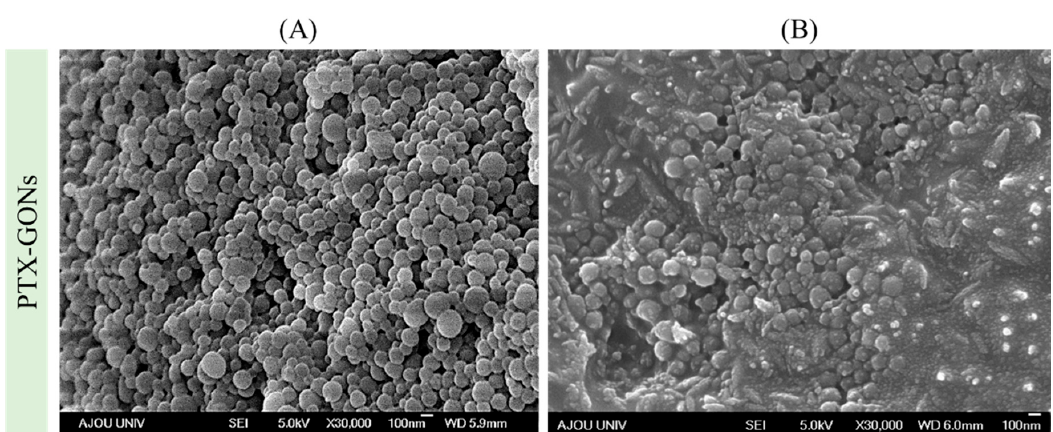
Figure 4. FE-SEM images of PTX-GONs according to states in the conditions: ( A ) the normal state and ( B ) the deformed state of PTX-GONs after shear stress was applied at 50 dynes/cm 2.